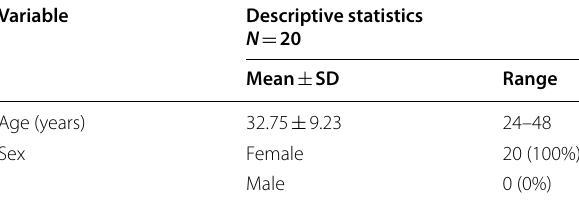
Fig. 5 Female patient 27-years-old with history of RRMS since 1 year presented by headache, EDSS respectively) show the arrow points to an abnormal high signal intensity intra-cortical lesion visualized at the right posterior high parietal level seen at DIR sequence and not visualized at other sequences